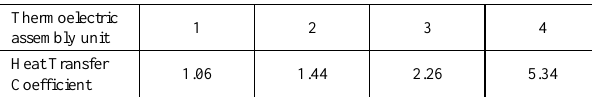
Thermoelectric assembly unit